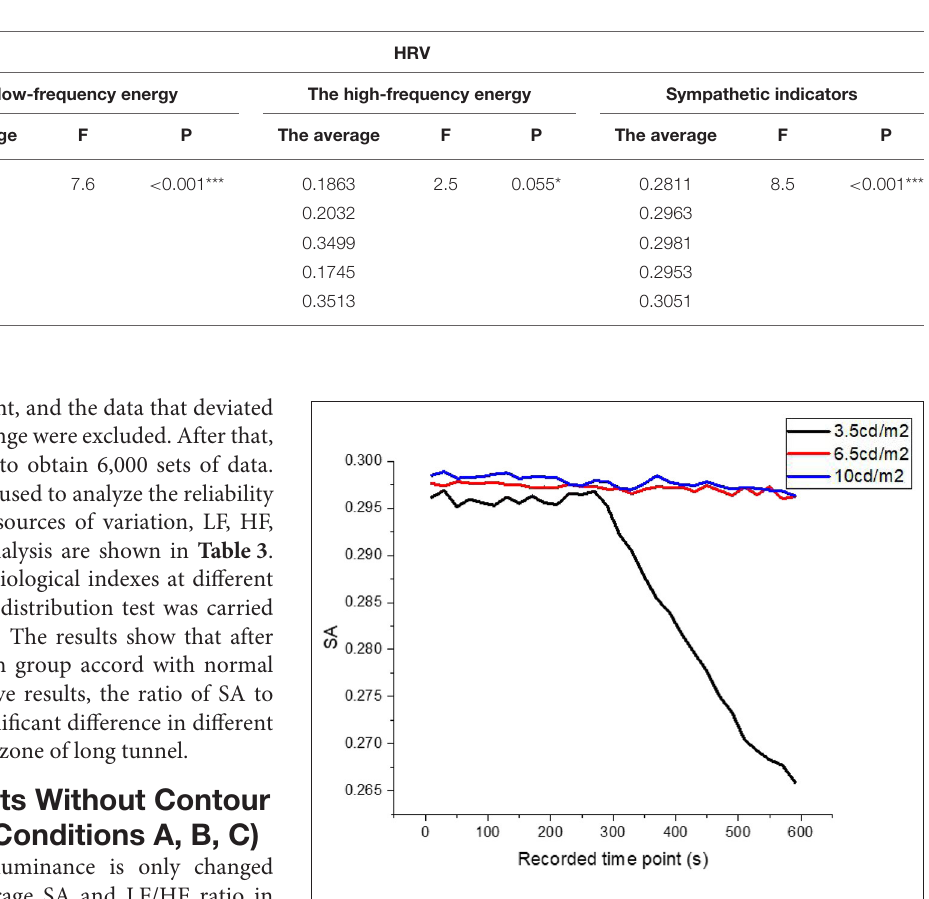
FIGURE 3 | When the road luminance is 3.5, 6.5, and 10 cd/m 2 , the variation trend of average SA of the